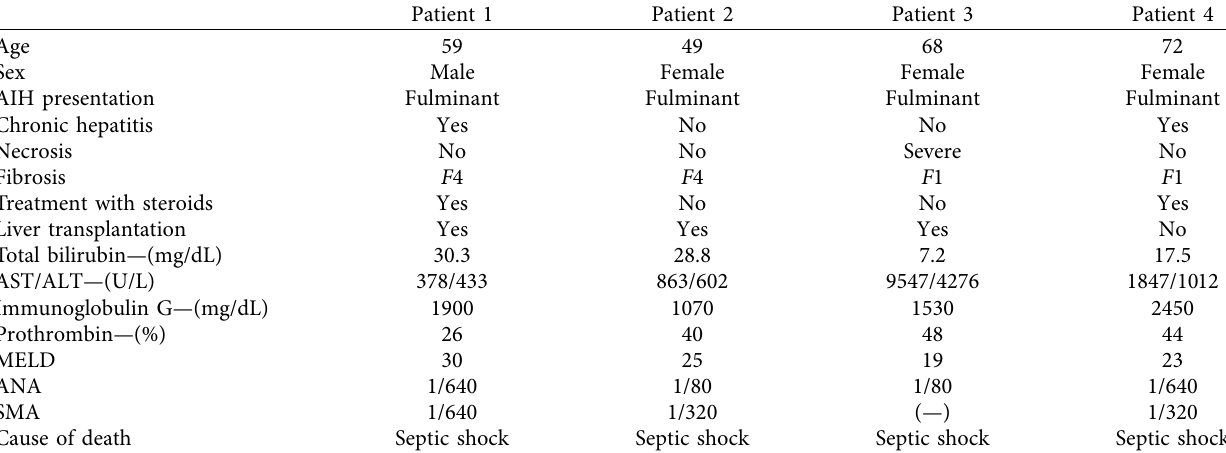
Table 4: Characteristics of the deceased patients.